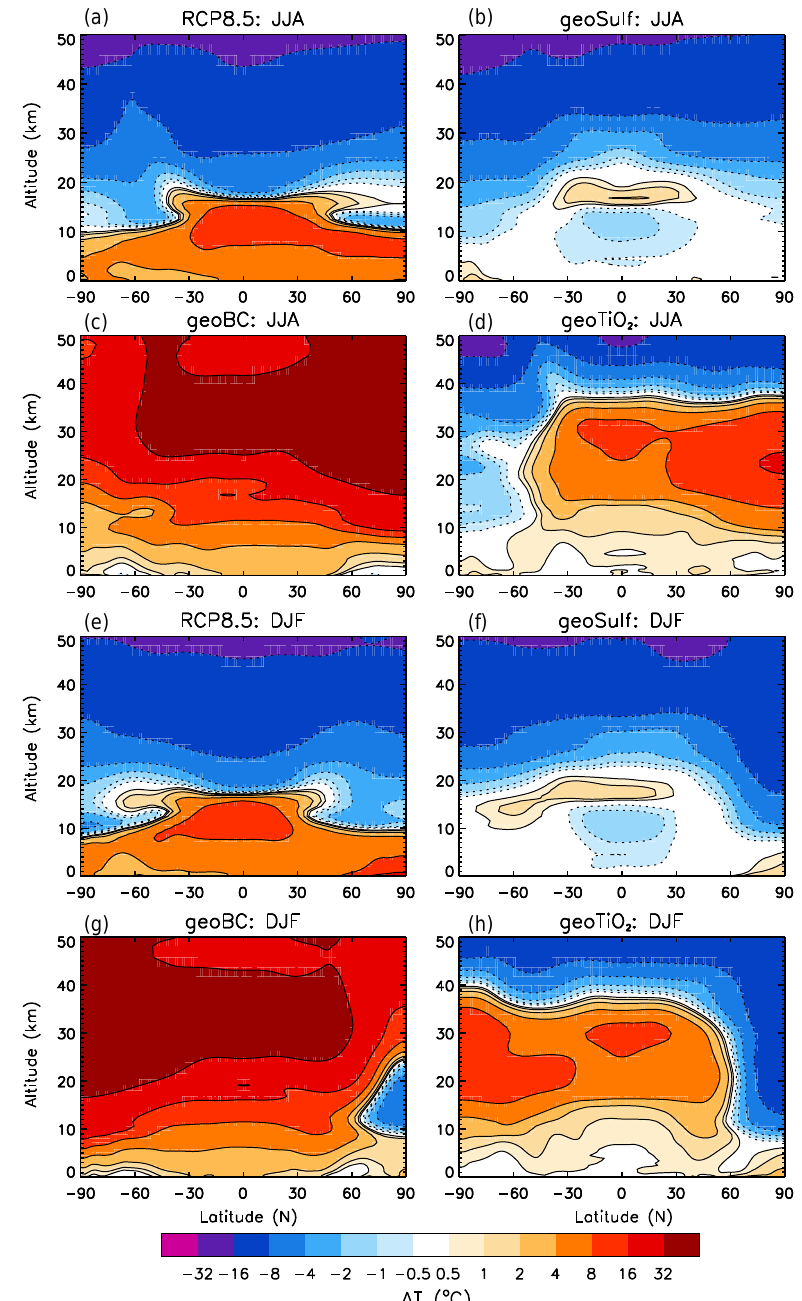
Figure 10. JJA (top) and DJF (bottom) zonal-mean temperature anomaly with altitude, with respect to HIST.